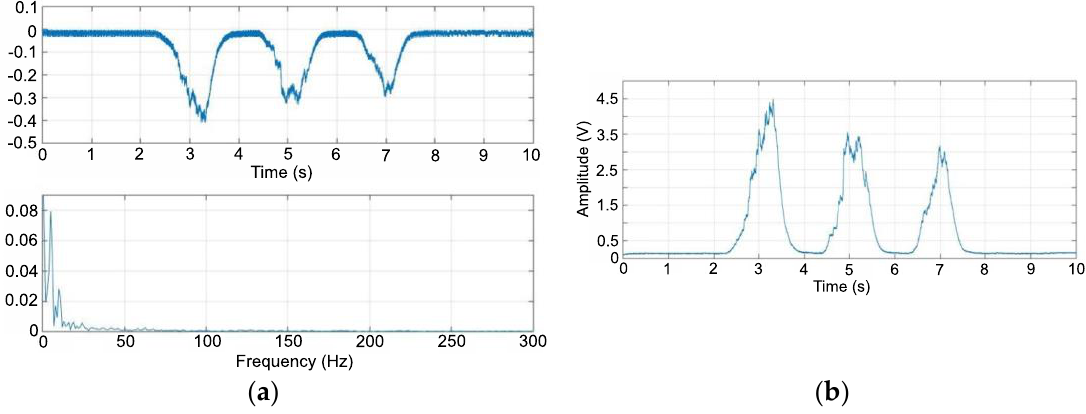
Figure 11. EMG signal as a function of time and frequency after low-pass filtering ( a ), EMG signal as a function of time after amplification using an inverting amplifier with adjustable gain ( b ).